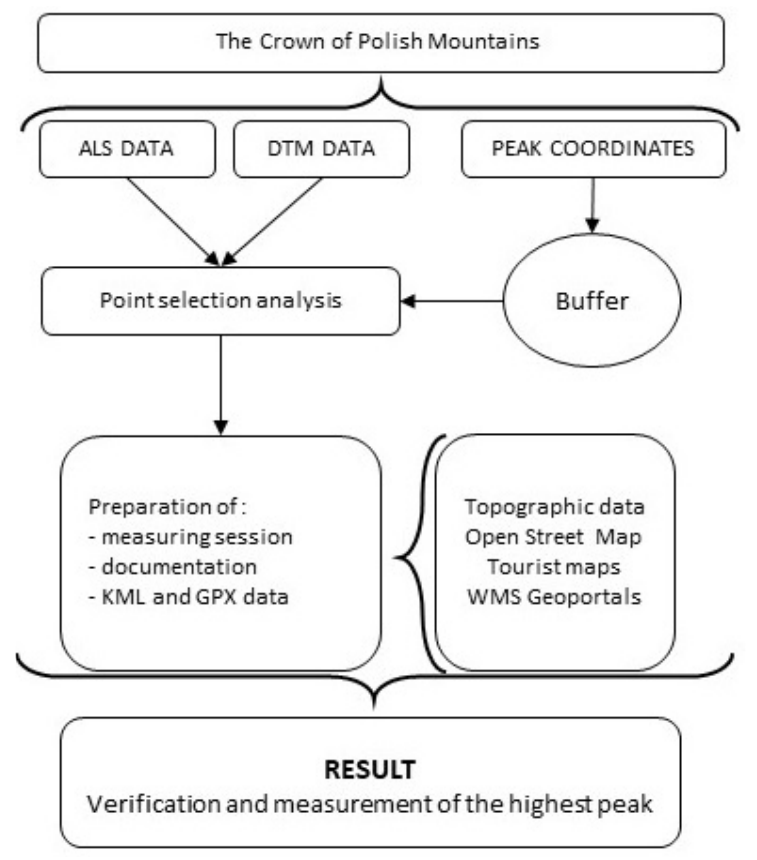
Figure 3. Diagram showing the data and the workflow for a single peak analysis.